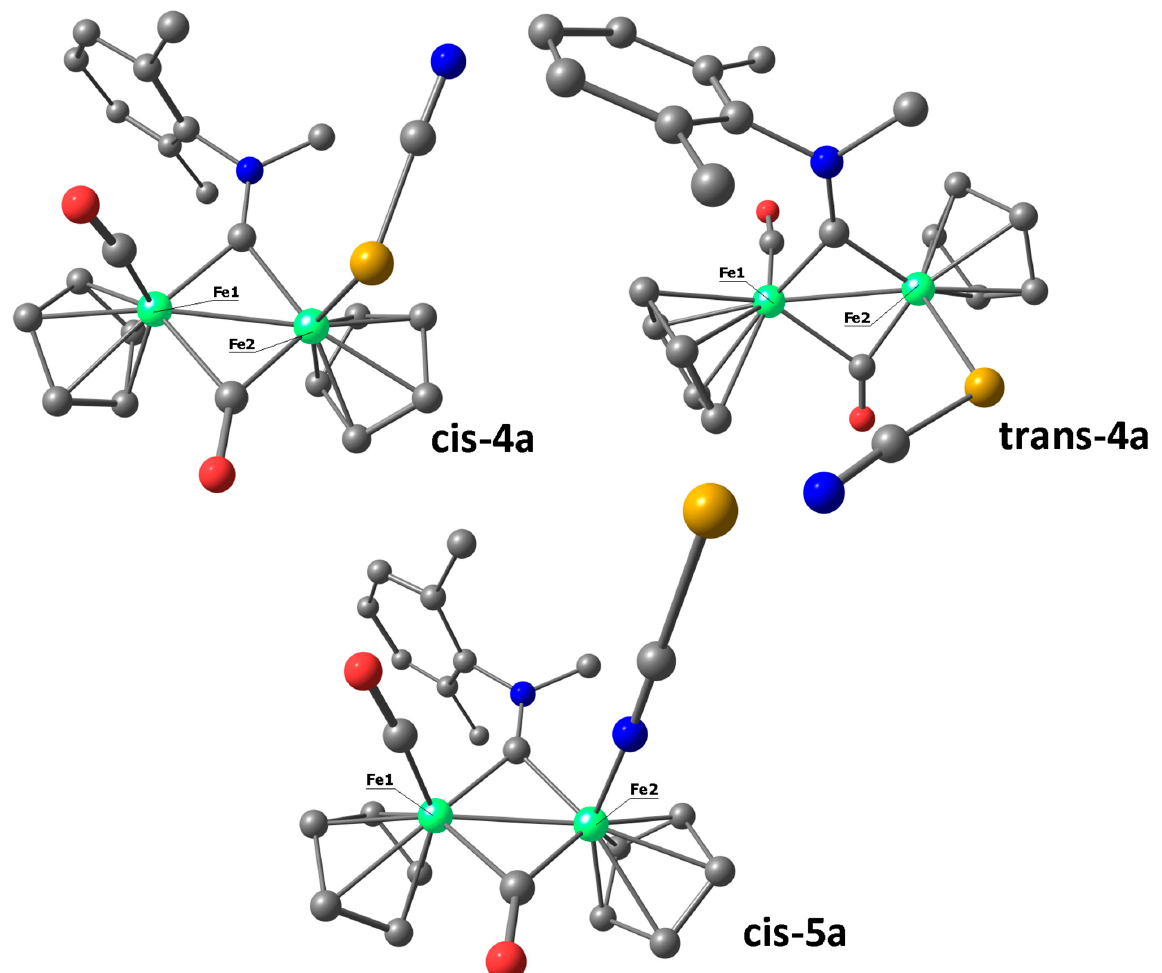
Figure 1. DFT-optimized structures of cis -4a , trans -4a , and cis -5a (C-PCM/PBEh-3c, acetone as continuous medium). Color map: Fe, green; Se, dark yellow; O, red; N, blue; C, grey; hydrogen atoms omitted for clarity. Selected computed bond lengths (Å): cis -4a , Fe1–C(CO) 1.766, Fe1–C( µ -CO)